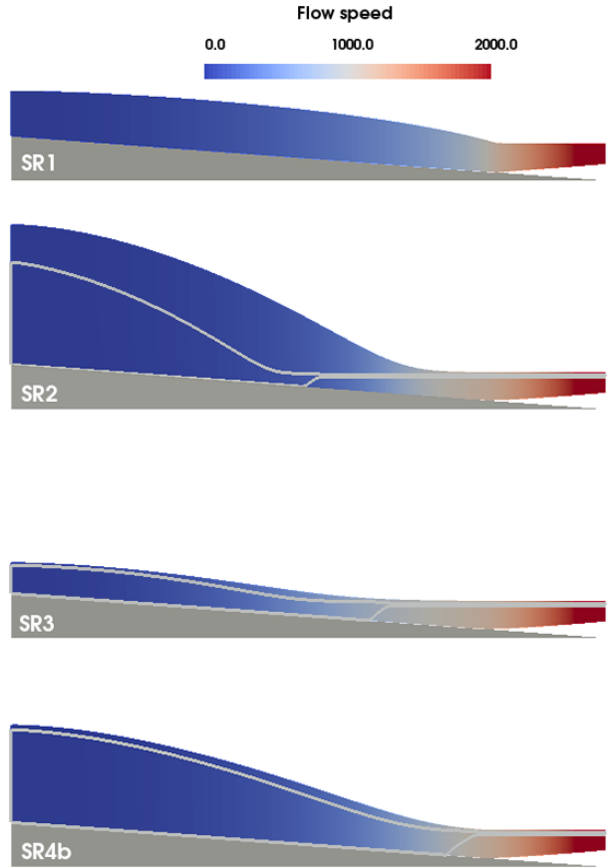
Figure 1. Ice geometry and velocity magnitude (ma − 1 ) at steady state from the ADVA experiment. Resolution R1 is shown, but these profiles do not vary significantly with resolution. These profiles pro- vide the starting point for the retreat simulations. The final state of the melt-induced experiment RHW is overlain in grey outline. Bedrock is shaded in grey. Vertical exaggeration is 150 times.